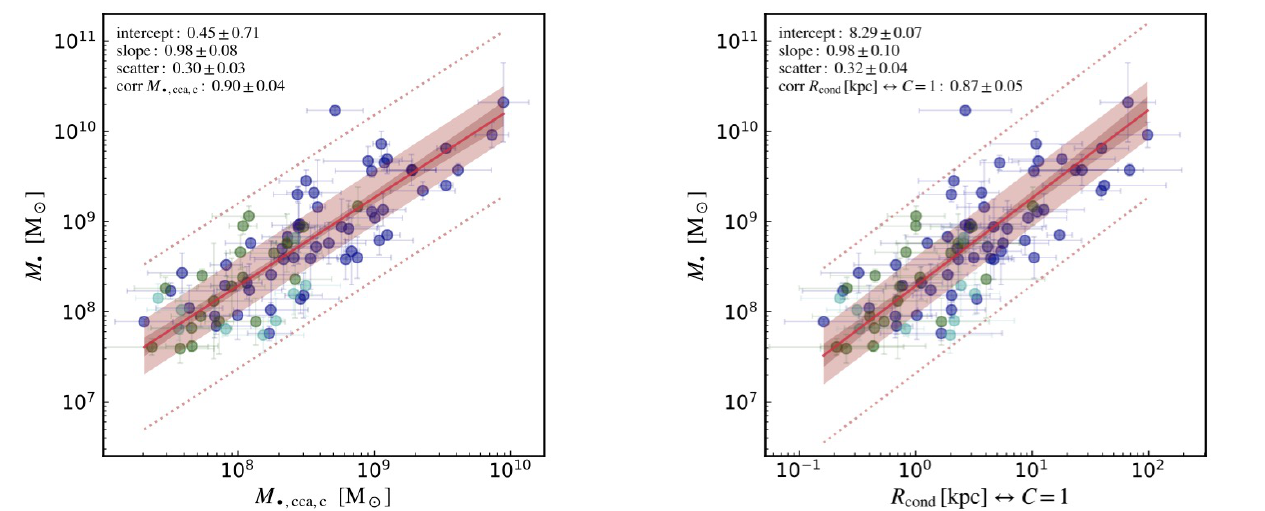
Figure 17. X-ray scaling relations are key to constrain different baryonic physics of the IGrM, here in terms of feeding models. Left : Direct SMBH masses plotted against the mass derived from theoretical/numerical predictions of chaotic cold accretion (CCA) via the X-ray core properties—adapted from Gaspari et al. [77]. Right : Hot-halo condensation radius as a function of BH mass and thus IGrM halo mass (the locus where C ≡ t cool / t eddy = 1; see Section 3.1.3 and Section 4.1). See Figure 12 for the description of the analysis, color coding, and sample. Figure reproduced from Gaspari et al.